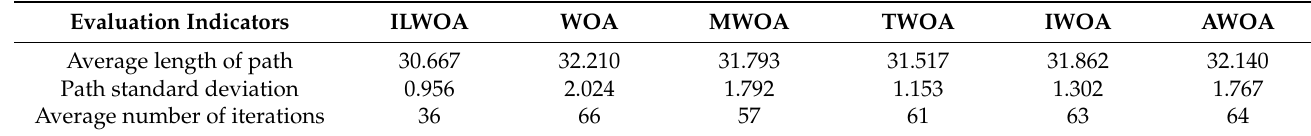
Table 4. Experimental results of Environment 1 scenarios.